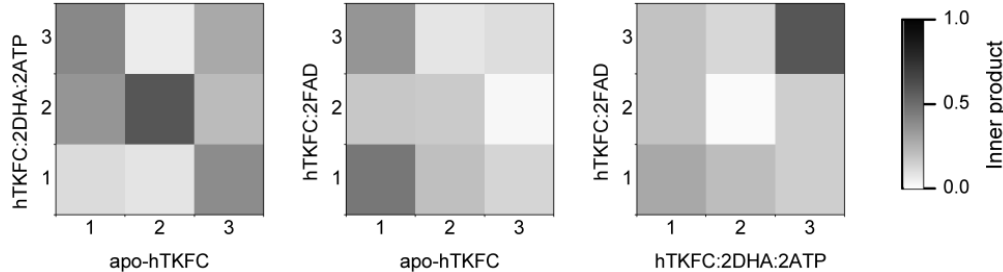
Figure 9. Comparison of principal components 1 – 3 for the systems studied. Inner products for each comparison are displayed in a grey scale: from 1.0, identity, to 0.0, orthogonality.